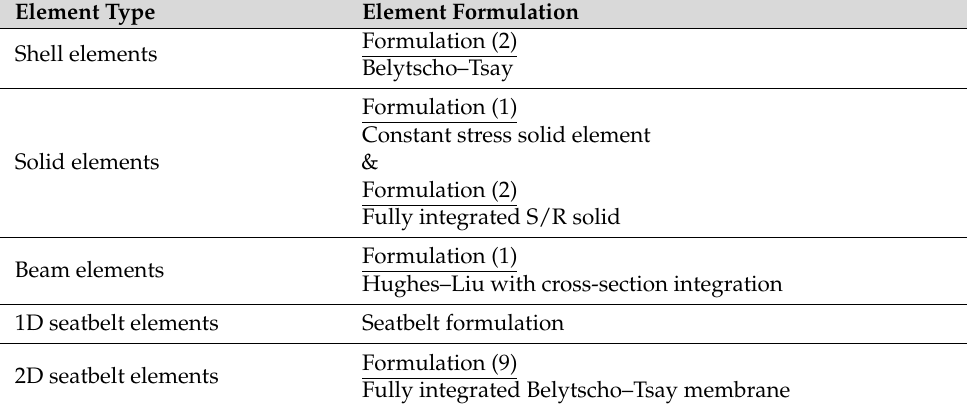
Table 7. Element formulations used in the models.